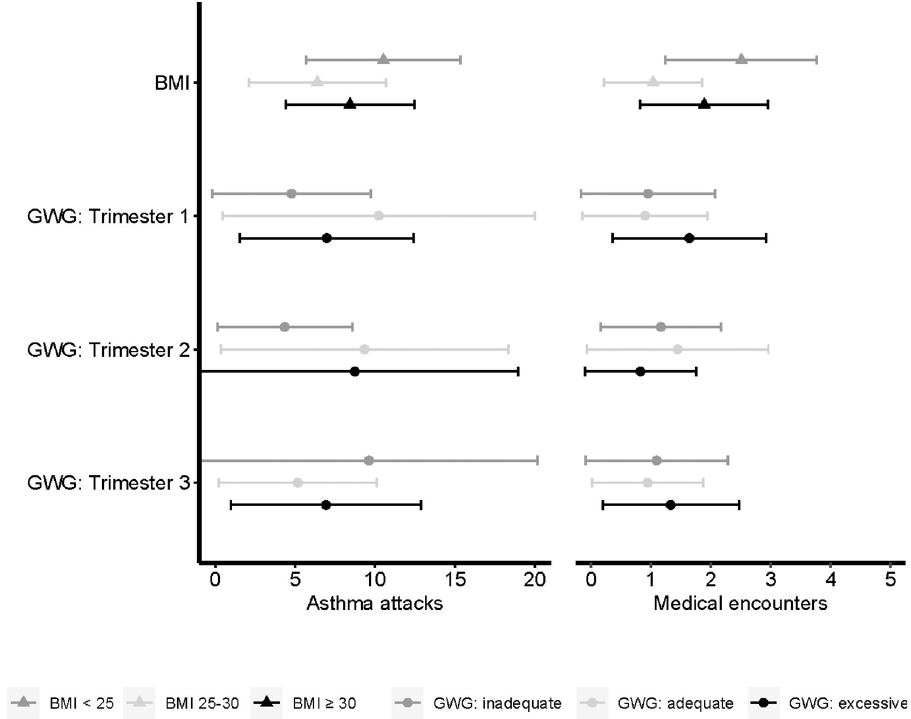
Fig 4. Estimated mean number and 95% confidence intervals for asthma exacerbations during pregnancy by pre- pregnancy BMI and GWG in the Breathe-Wellbeing, Environment, Lifestyle, and Lung Function Study, 2015– 2019, USA. Abbreviations: BMI, body mass index; GWG, gestational weight gain.